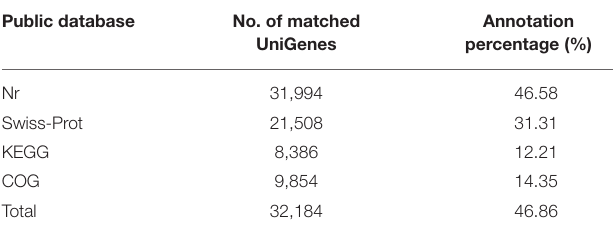
TABLE 2 | UniGenes mapped to the public